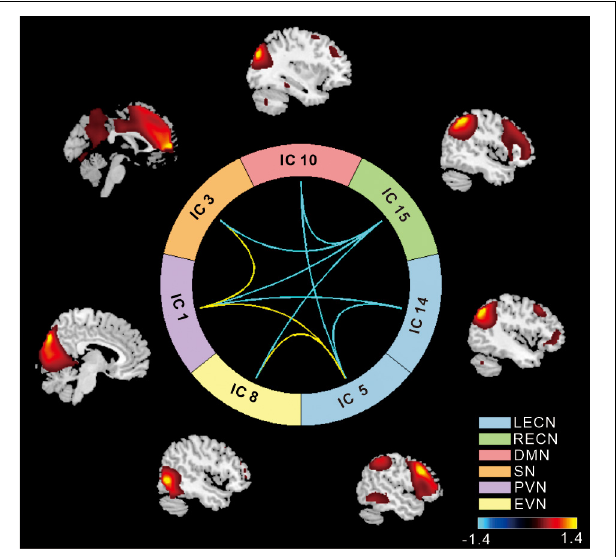
FIGURE 1 | The cool color scale represents negative values, indicating hypoconnectivity (decreased positive correlation, or greater anti-correlation) in patients with type 2 diabetes mellitus (T2DM) relative to normal controls (NCs); the hot color scale represents positive values, indicating hyperconnectivity (increased positive correlation or less anti-correlation) in patients with T2DM relative to NCs. LECN, left executive control network; RECN, right executive control network; PVN, primary visual network; EVN, extrastriate visual network; SN, salience network; DMN, default mode network ( p < 0.05, false discovery